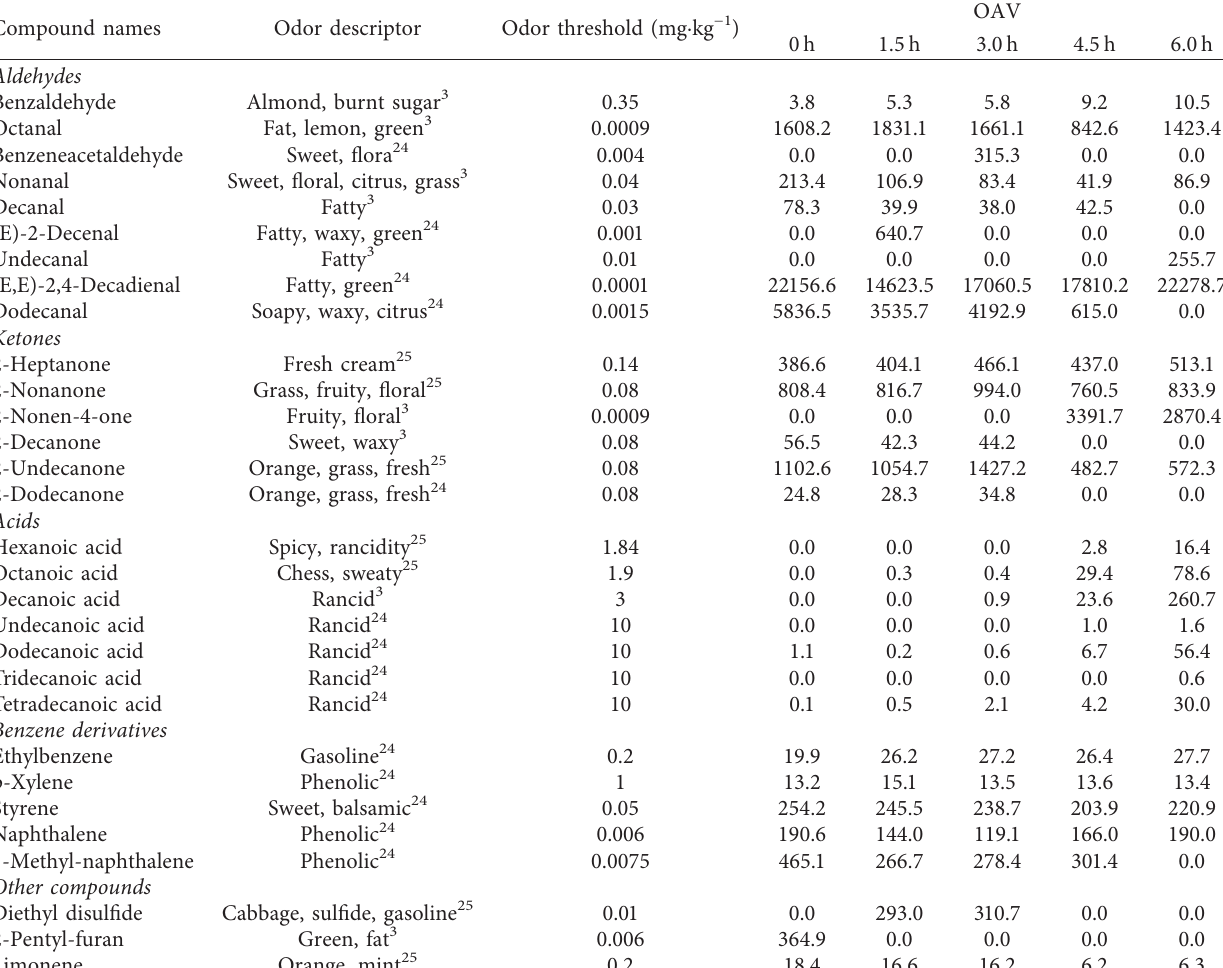
Table 2: OAVs of volatile compounds in yogurt fermented by S. thermophilus at different